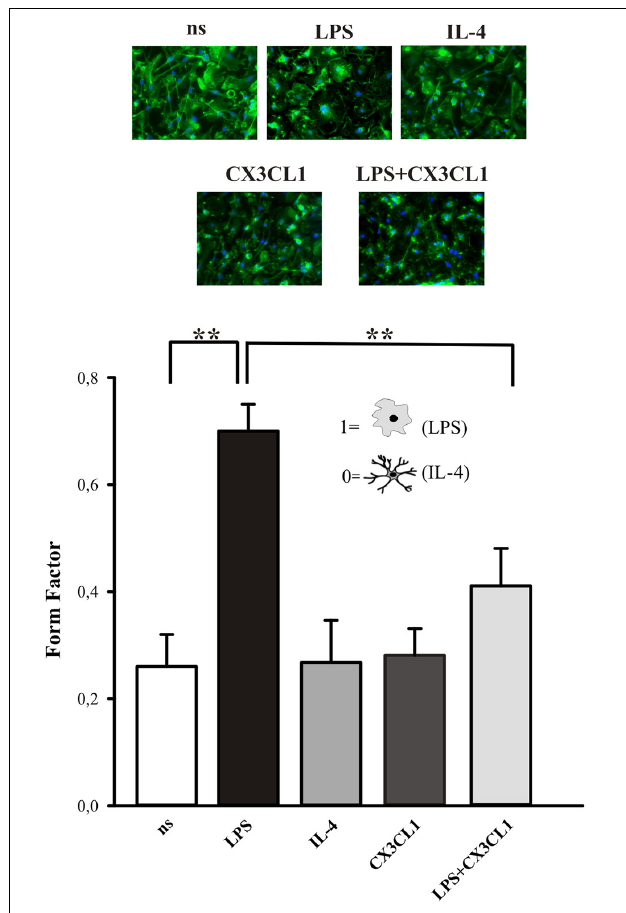
FIGURE 2 | CX3CL1 induces change in microglia shape in culture. Upper panel: fluorescence images of microglia in culture stimulated with LPS, IL-4, CX3CL1, LPS + CX3CL1 and stained with Alexa-Fluor 488 Phalloidin. Lower panel: form factor analysis of microglia cells treated with LPS (pro-inflammatory stimulus) IL-4 (anti-inflammatory stimulus), CX3CL1, LPS + CX3CL1. Statistical analysis: Data are expressed as the mean ( ± SEM.) of n = 20 cells for each condition, ∗∗ p < 0.001, Student’s t-